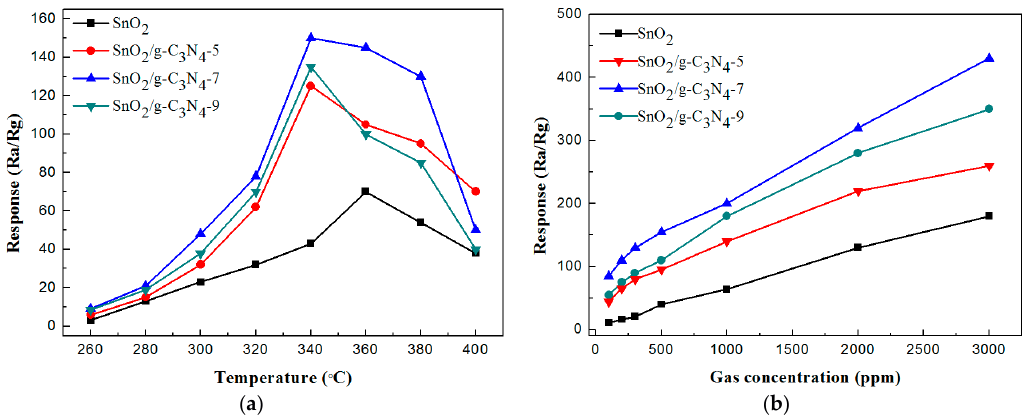
Figure 5. The response values of the SnO 2 , SnO 2 /g-C 3 N 4 -5, SnO 2 /g-C 3 N 4 -7, and SnO 2 /g-C 3 N 4 -9 to 500 ppm ethanol ( a ) under different operating temperatures; ( b ) for different concentrations of ethanol at 340